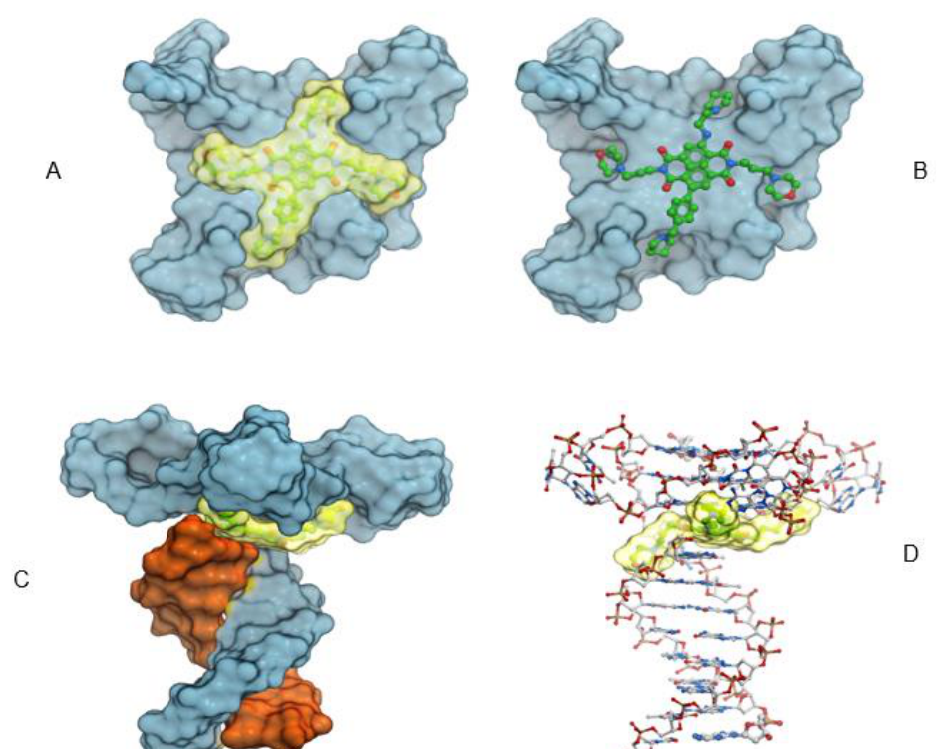
Figure 6. Four views of the docked model of QN-302 with a quadruplex–duplex model structure. In ( A – C ) the quadruplex-forming strand is colored grey and the complementary duplex stem shown in ( C ) is colored orange. ( A , B ) were drawn viewing the G-quartet and QN-302 plane and show the four substituents each in a quadruplex groove. In each instance the quadruplex is drawn as a grey solvent-accessible surface. A shows the QN-302 molecule as a yellow solvent-accessible surface, and in ( B ) it is shown in ball-and-stick mode. In ( C , D ) the complete quadruplex-duplex model is shown together with bound QN-302 in solvent accessible representation and colored yellow. ( D ) (with the DNA shown in stick mode) shows that one of the morpholino groups OF QN-302 has interactions in a groove at the junction of the G4-duplex DNA (with an N3 atom).